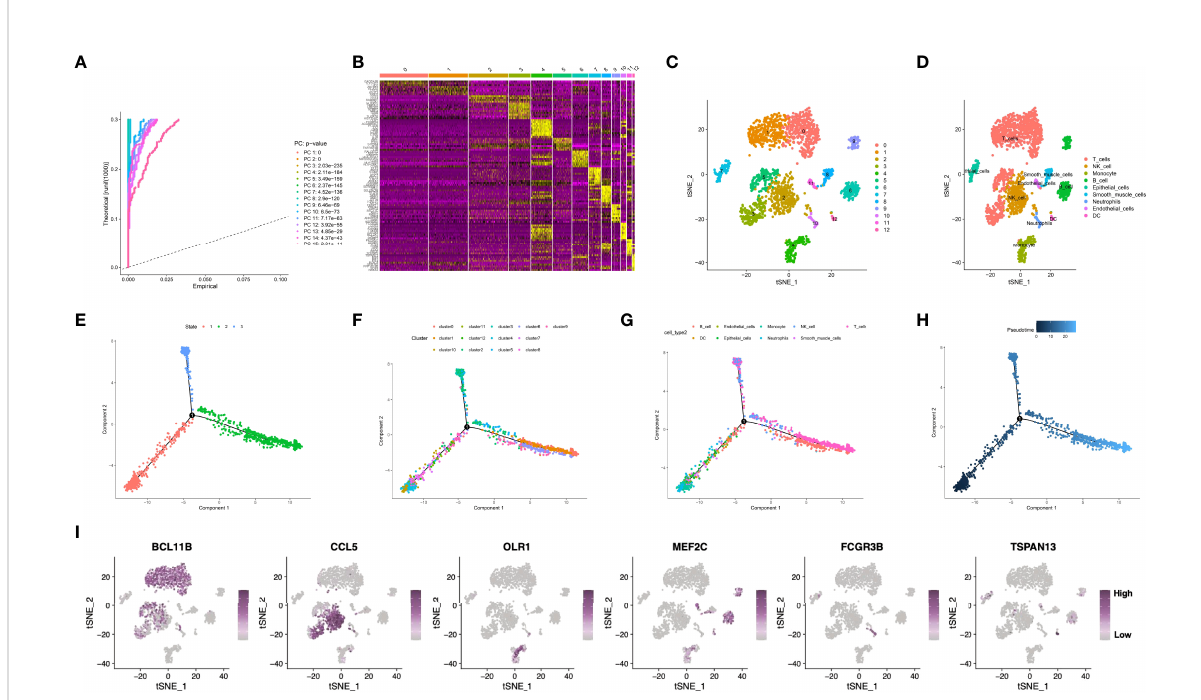
FIGURE 1 (A) Fifteen PCs with signi fi cant differences were identi fi ed at P<0.5. (B, C) All cells were clustered into thirteen clusters, and the top 10% of marker genes in each cluster are displayed on the heat map. (D) Nine clusters were annotated based on marker genes. (E – H) Pseudo-time and trajectory analysis. (I) The six classes of immune cells and their most prominent marker genes were shown. PCA, principal component analysis; PC, principal component; GC, gastric